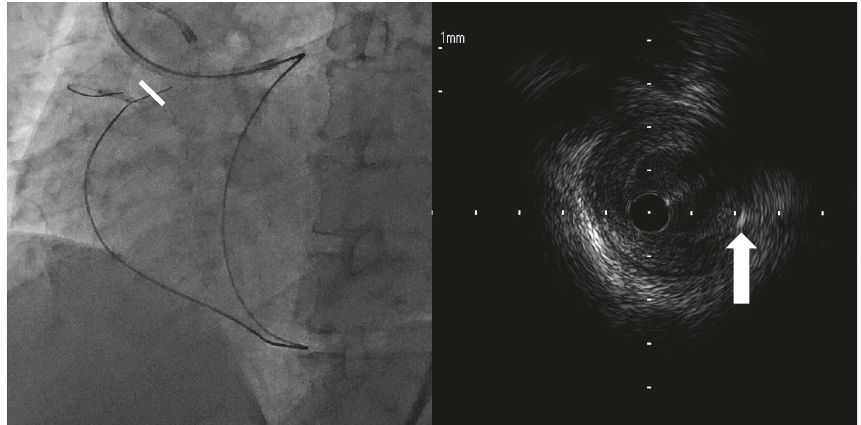
Figure 3: The intravascular ultrasound revealed that the retrograde guidewire (white arrow) was in the subintimal space at the proximal right coronary artery past the chronic total occlusion.